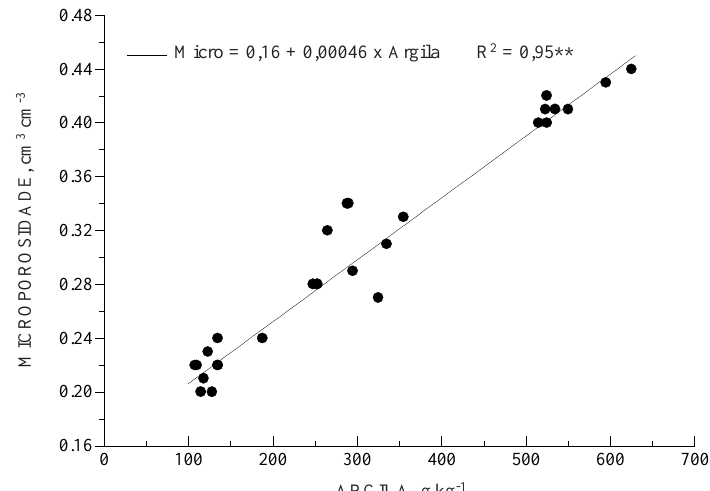
Figura 5. Relação entre a microporosidade e os teores de argila do solo dos perfis profundos e rasos no Argissolo Vermelho distrófico arênico. n = 28 pares, ** significativo a 1% pelo teste